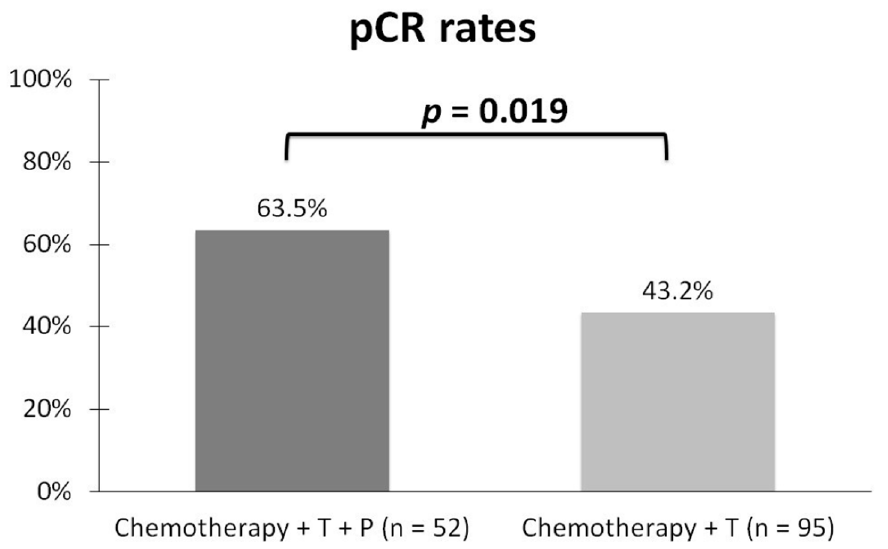
Figure 1. The significant differences of pathologic complete remission (pCR) after neoadjuvant chemotherapy combined with dual-blockade or single-blockade therapy. T, Trastuzumab; p , Per- tuzumab. Table 2. pCR by characteristics.